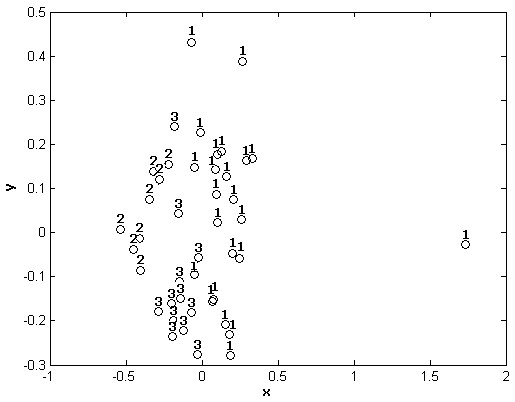
Sammon's mapping analyses on the SRBCT data. Symbols "1", "2" and "3" represent classes EWS, RMS and BL respectively.